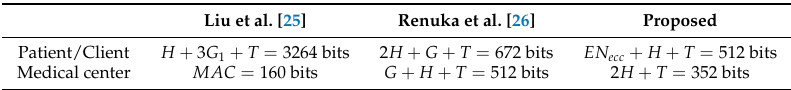
Table 4. Communication costs of the proposed scheme with related schemes.